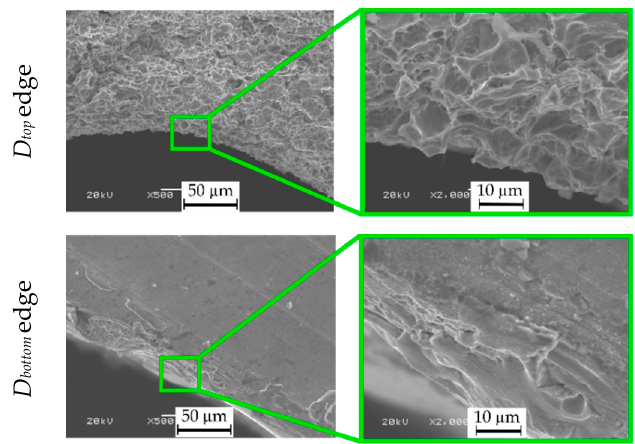
Figure 21. SEM images of the surface of D top and D bottom edge, hole No. 3.